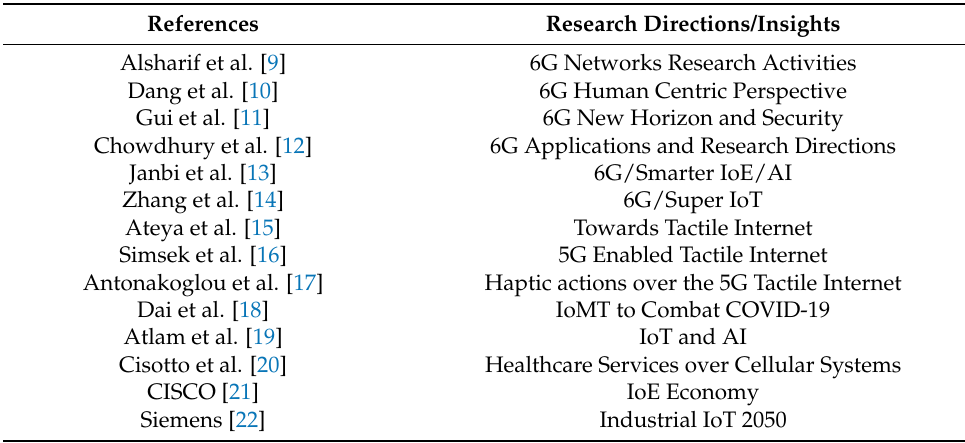
Table 1. Summary of the 6G/Tactile Internet/CDI/IoHE literature review.